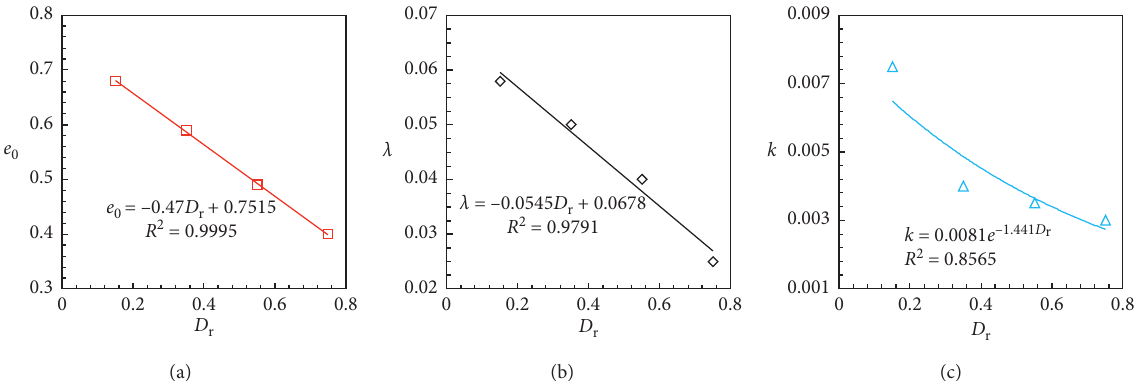
Figure 16: Relationships between D r and e 0 , λ , and k . (a) D r -initial pore ratio e 0 . (b) D r -compression coefficient λ . (c) D r -rebound coefficient k .